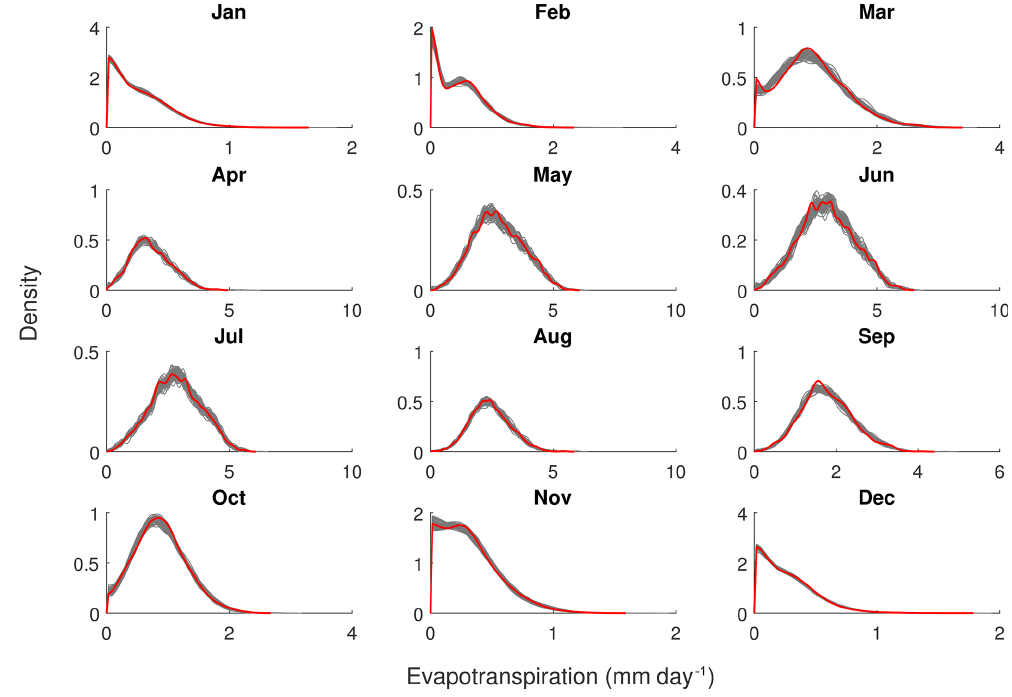
Figure 4. Comparison between the probability density functions of evapotranspiration of observed and simulated values: Uccle is in red and the ensemble of 50 time series simulated using the C-vine copula V TPE